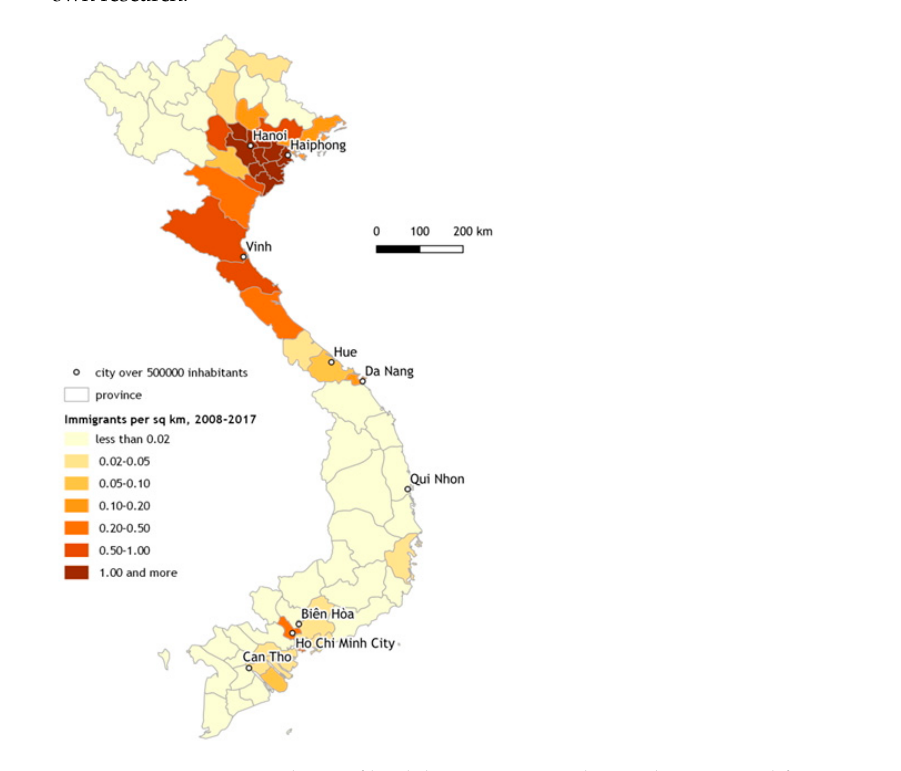
Figure 3. Immigrants’ places of birth by provinces – those who migrated from Vietnam to Czechia between 2008 and 2017, including both permanent and temporary residence permits. Source: our own research.